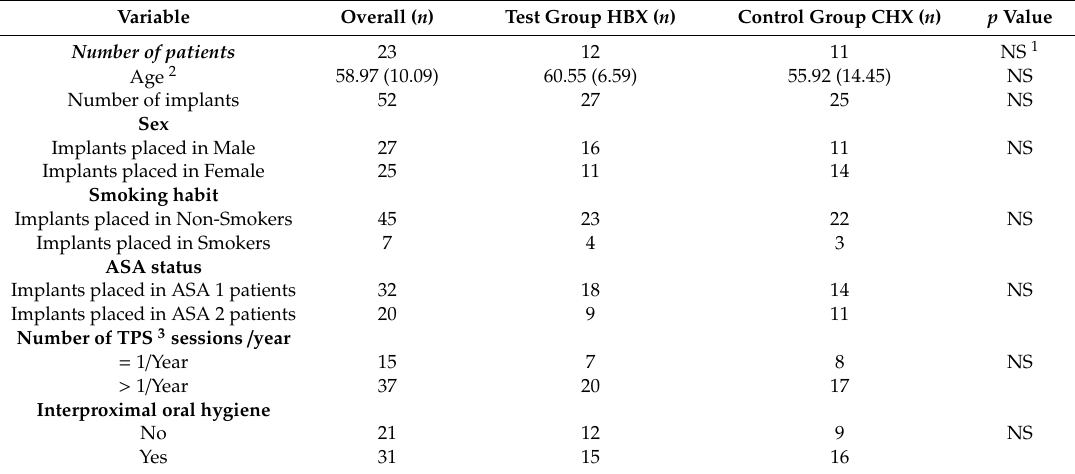
Table 1. Patients and implants characteristics at baseline (T0).